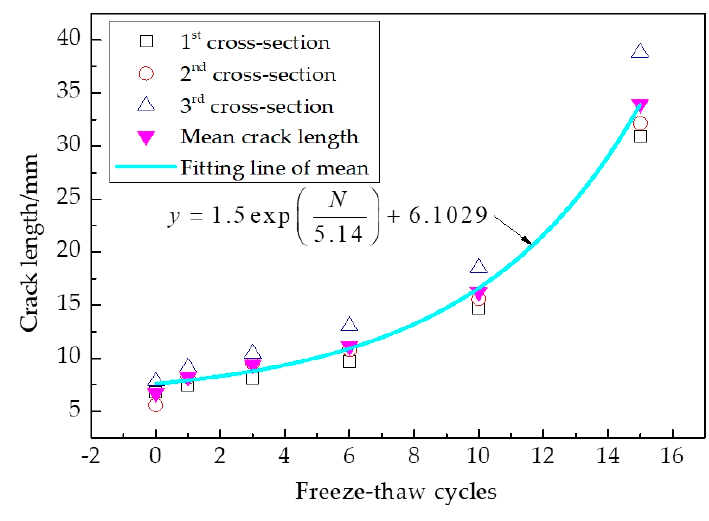
Figure 5. Relationship between crack length and freeze-thaw cycling.